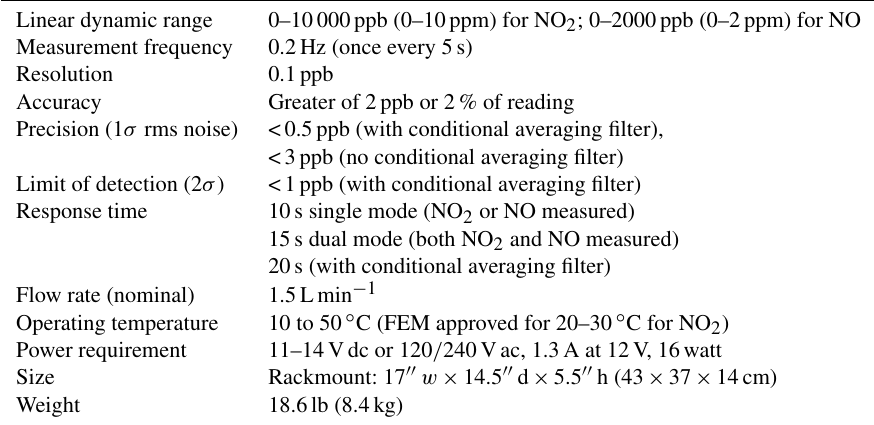
Table 1. Analytical and physical specifications, 2B Technologies model 405nm NO 2 / NO / NO x folded tubular photometer.